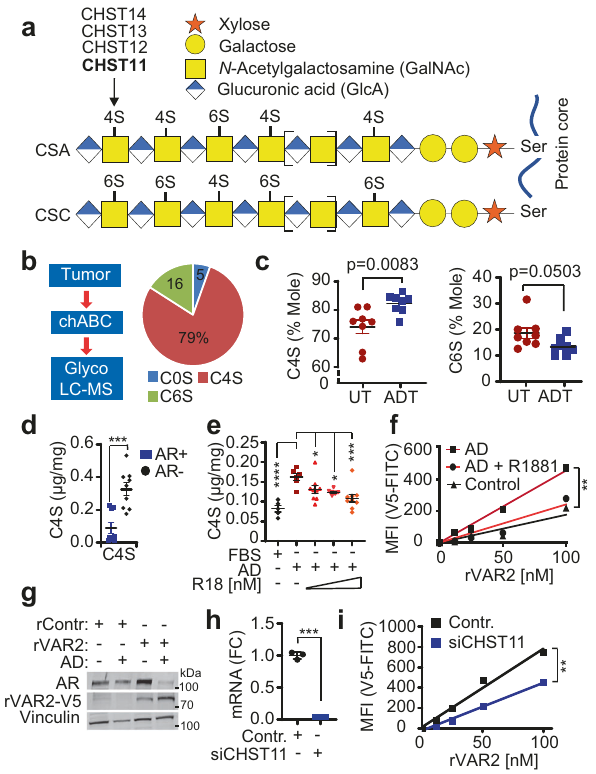
Fig. 4 | Expression of chondroitin sulfate A is controlled by AR in prostate cancer. a Schematic of CS chains, their sulfations sites C4S and C6S. b CS was puri fi edfromparaf fi n fi xedPCpatients ’ samplesusingchondroitinaseABCenzyme (Chase)andsubjectedtoLC-MSanalysis.TheC0S,C4S,andC6Smolepercentages were calculated as the percentage of the total moles of disaccharides (C0S+ C4S+C6S). Data are shown as the average percentage of moles of 16 PC patients. c Quanti fi cation of C4S and C6S of tissues from androgen deprivation therapy- treated (ADT, n =8) and untreated (UT, n =8) high-risk PC patients using LC-MS; mean±SEM;Twotailed t test. d LC-MSC4SlevelsinAR(+)celllines(LNCaP,VCaP, 22RV1) and AR ( − ) cell lines (PC3, Du145, IGR-CaP1). n =9 samples (three cell lines and three biologically independent replicates); mean±SEM; p =0.0003 by two- tailed t test. e LC-MS C4S quanti fi cation in LNCaP cells after 72h of AD condition and 48h of treatment with 1, 5, or 10nM of R1881. AD n =6; FBS n =5, p <0.0001; AD+R18[1nM] n =9, p =0.05; AD+R18[5nM] n =9, p =0.014; AD+R18[10nM] n =9biologicallyindependentsamples, p =0.0006byone-wayANOVAfollowedby Dunnett correction; data represented as mean±SEM. f CSA expression levels in LNCaP cells in ambient conditions and AD conditions (7 days) determined by fl ow cytometry using rVAR2 lectin; linear regression followed by Ancova test; p =0.0272, F =5.529, DFn=2, DFd=9. g CSA and AR expression levels in LNCaP cells in ambient and AD conditions (7 days) determined by western blotting using rVAR2-V5 lectin and V5 antibody. h CHST11 mRNA levels 48h after CHST11 knock- down. Data are shown as fold change (FC) mean±SD; n =3 biological replicates. i CSA expression levels in PC3 cells 48h after siCHST11 determined by fl ow cyto- metry using rVAR2 lectin and anti-V5 antibody. linear regression followed by Ancova test; p =0.0448, F =6.387, DFn=1, DFd=6. Representative data of